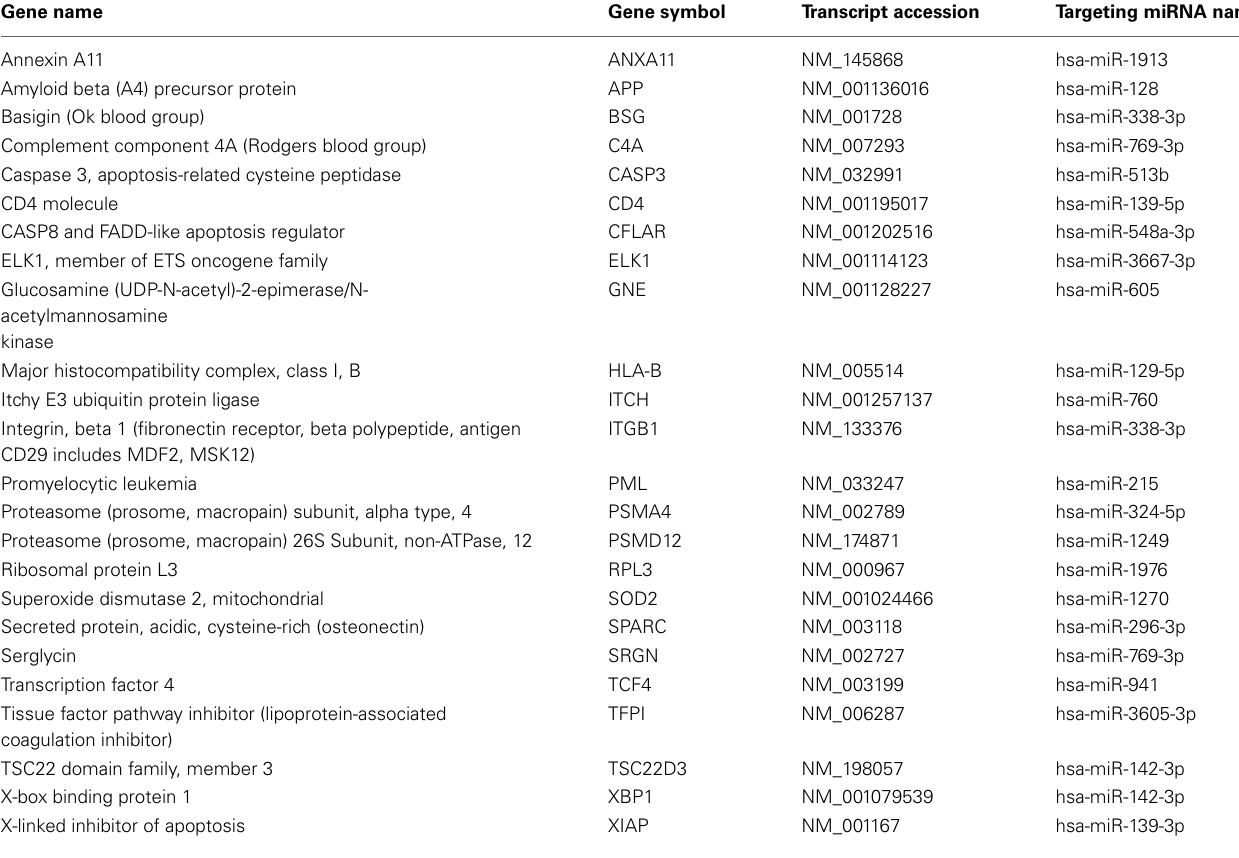
Table 2 | Host immune response associated genes targeted by miRNAs in KSHV infected PEL